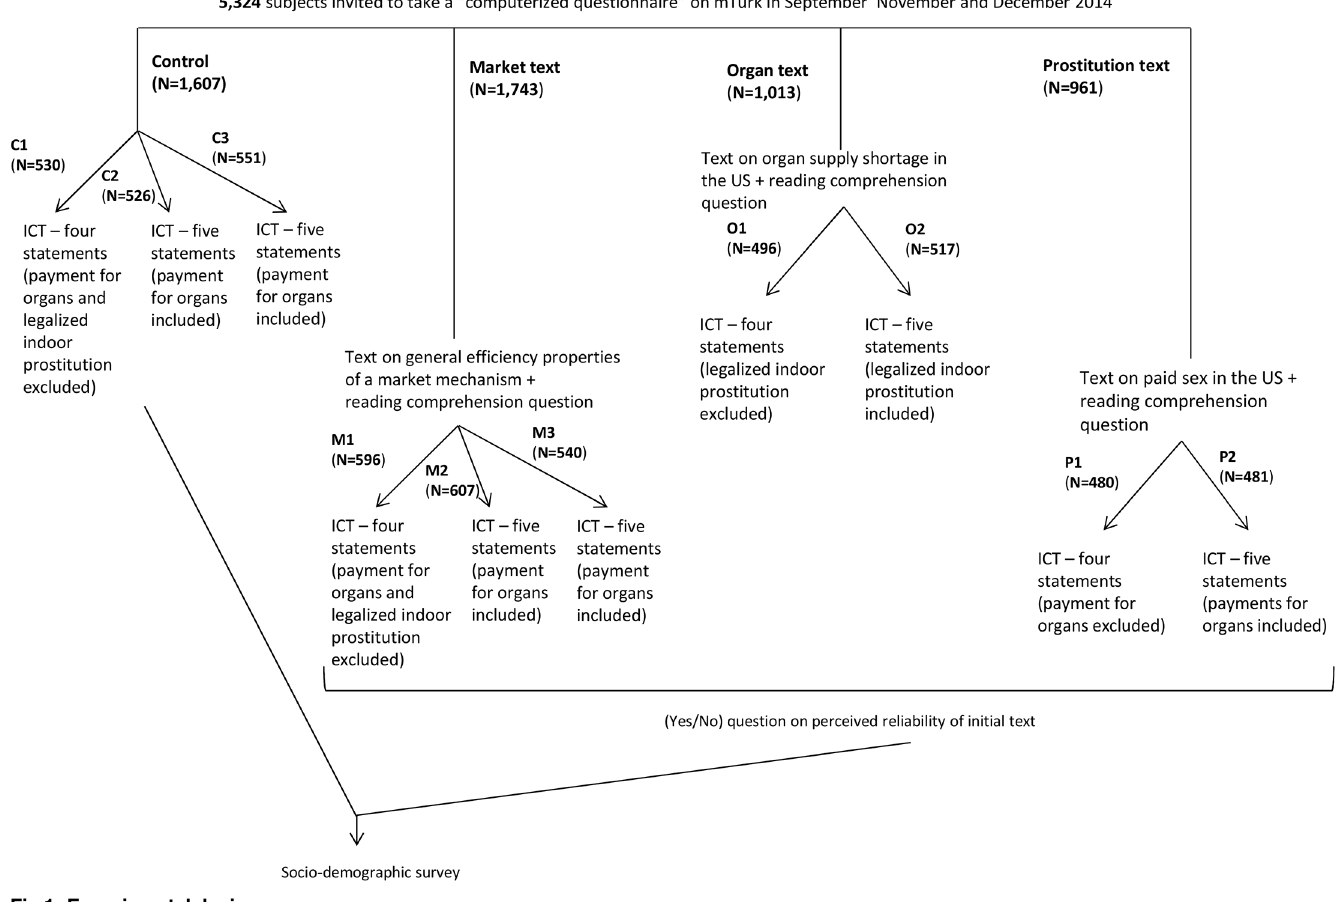
Fig 1. Experimental